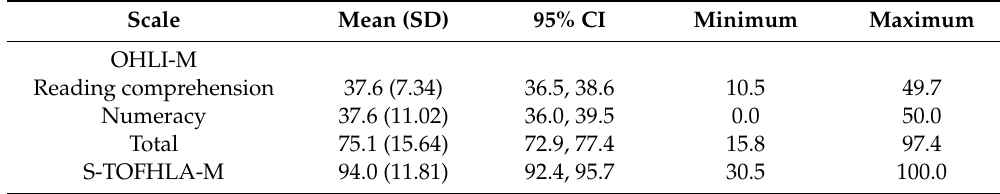
Table 2. OHLI-M and S-TOFHLA-M scale level statistics ( n = 195).